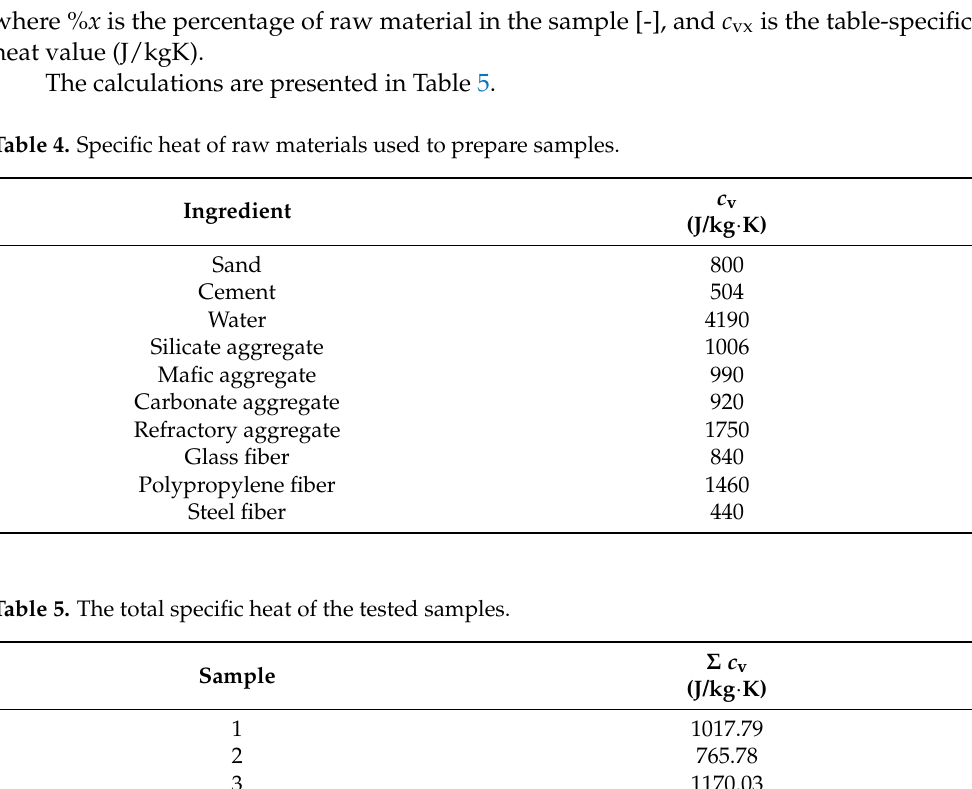
Table 5. The total specific heat of the tested samples.